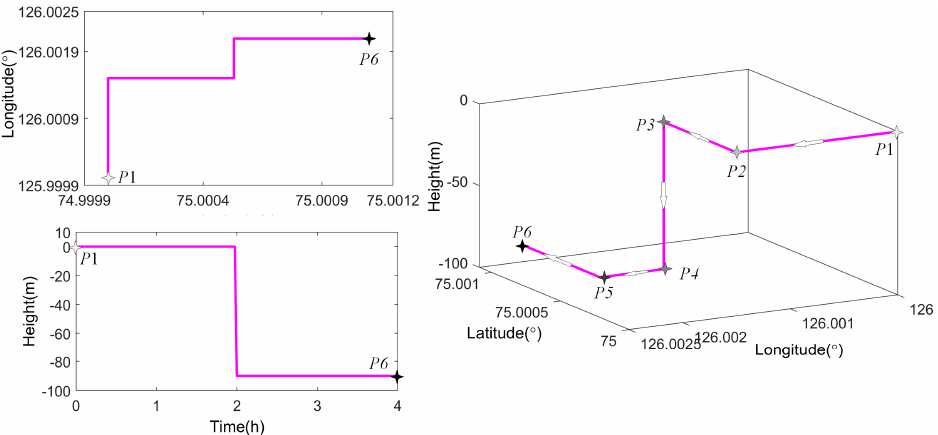
Figure 10. Description of the designed vehicle trajectory.